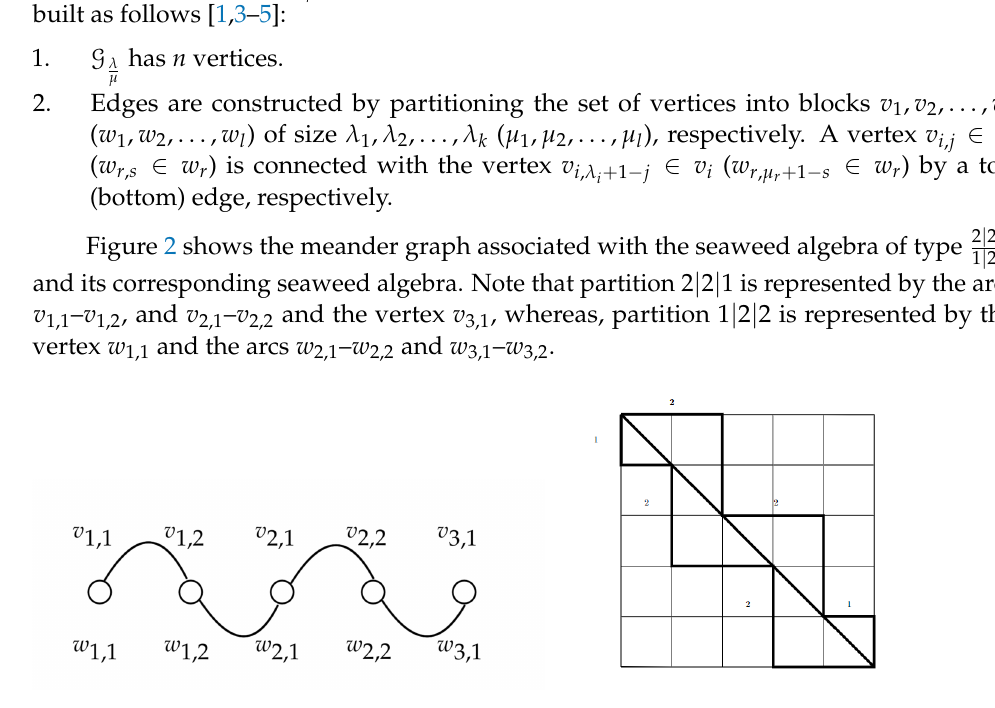
Figure 2. Meander graph associated with the compositions {2, 2, 1} and {1, 2, 2} and the corresponding seaweed Lie